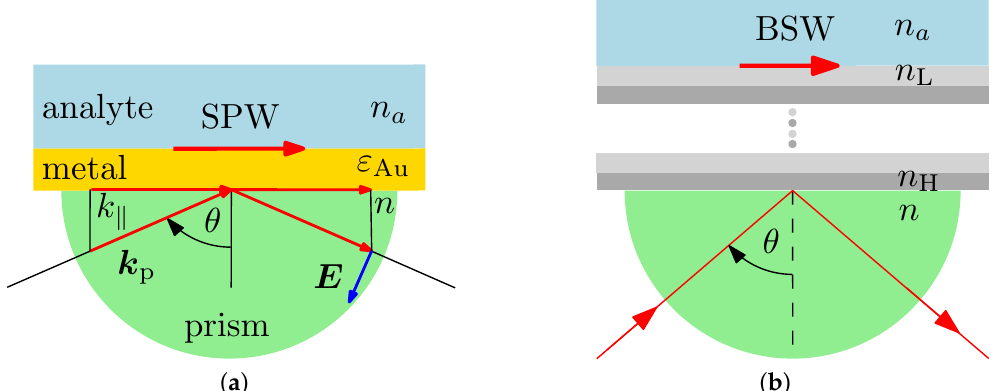
Figure 1. The Kretschmann configuration: coupling of an optical wave into the SPW ( a ) and the BSW, respectively ( b ).